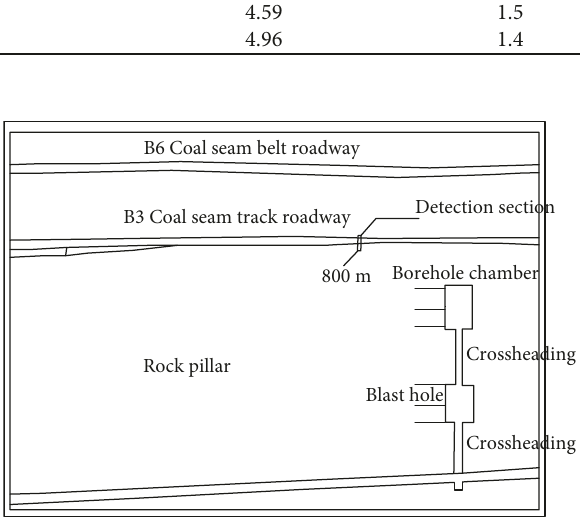
Figure 17: Layout of the detection section of track roadway in B3 coal seam.